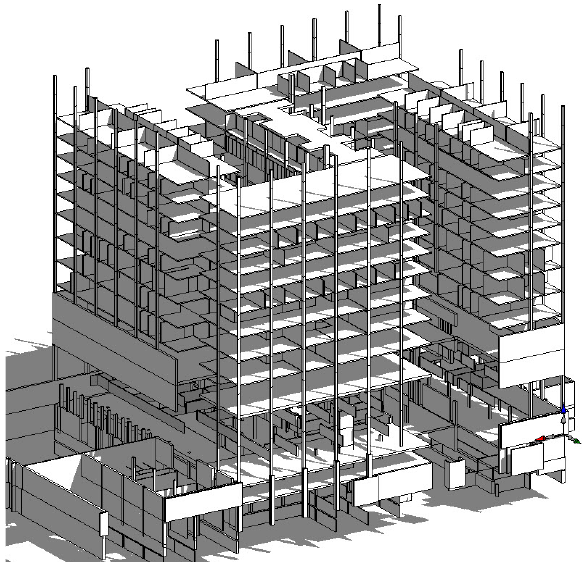
Figure 6. A big part of the campus modelling done using algorithms to automate the process.